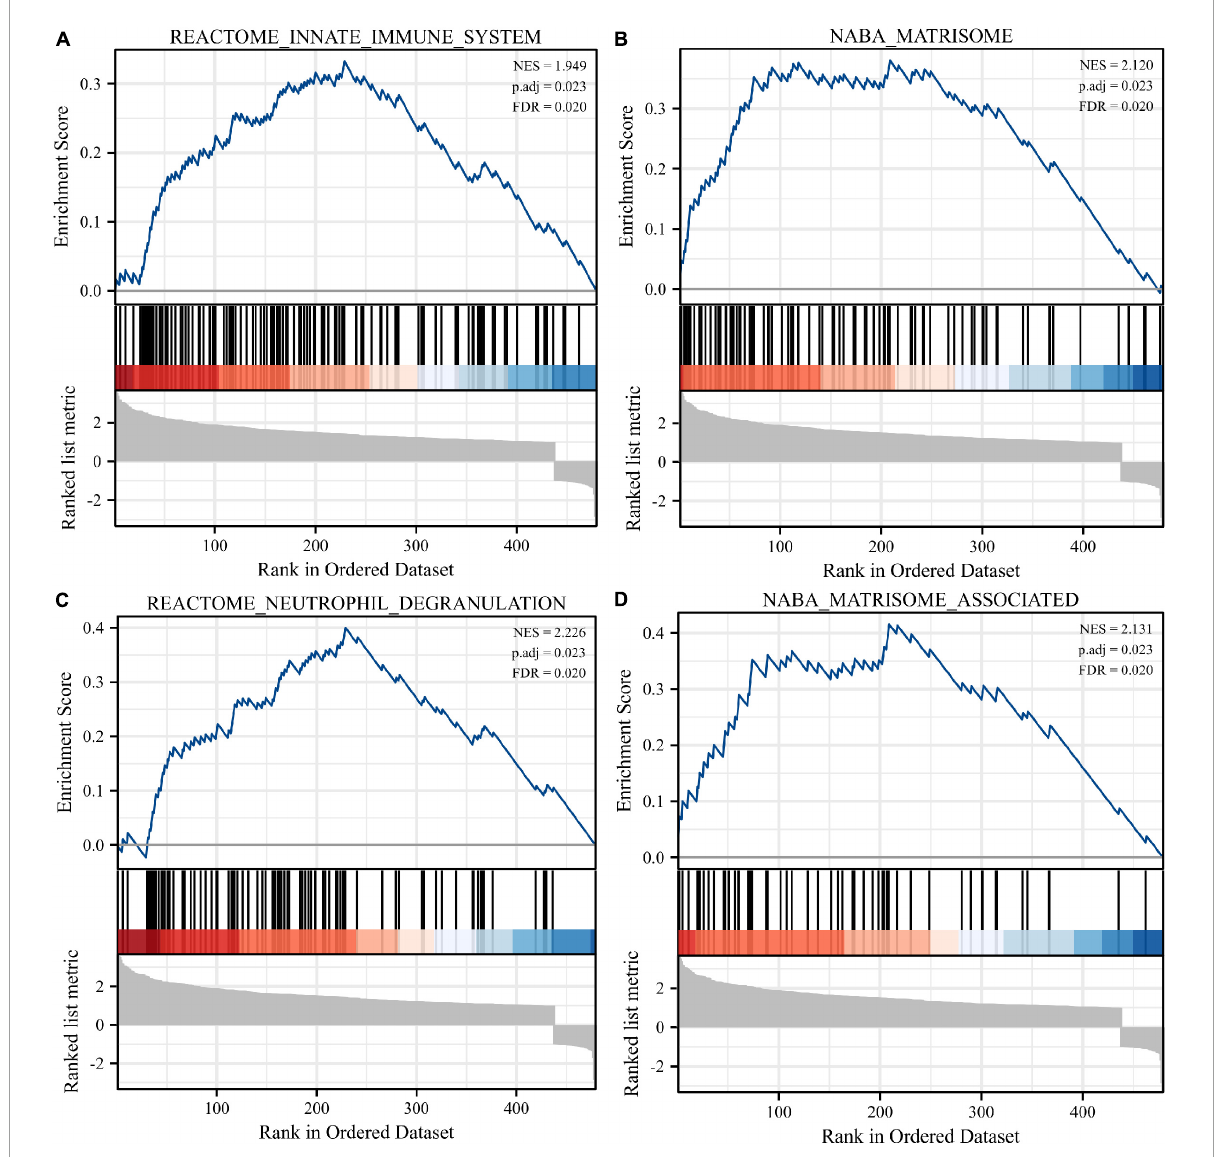
FIGURE3 Enrichment analyses using gene set enrichment analysis (GSEA). Four significant gene set enrichment pathways (FDR < 0.25, adjusted p < 0.05). (A) Reactome innate immune system. (B) Naba matrisome. (C) Reactome neutrophil degranulation. (D) Naba matrisome associated. FDR, false discovery